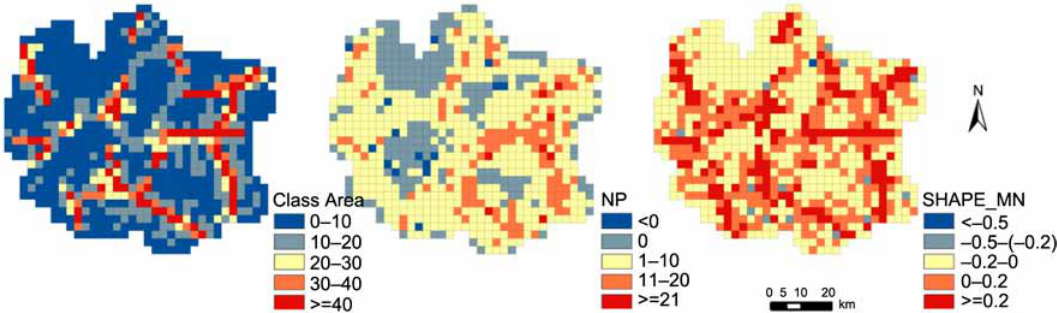
Fig. 15. Binary comparison between DDS scenario and observed landscape pattern 2010 in Class Area, NP, and SHAPE_MN values